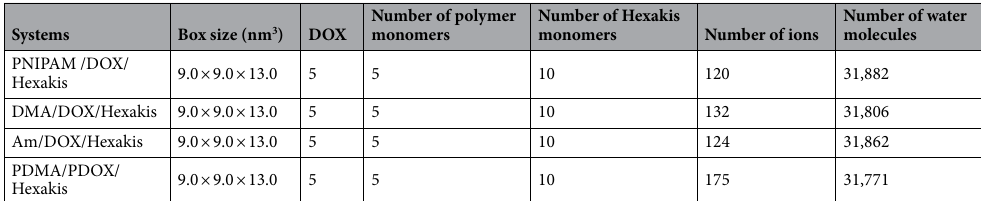
Table 1. Simulation details of studied DOX–polymer–Hexakis